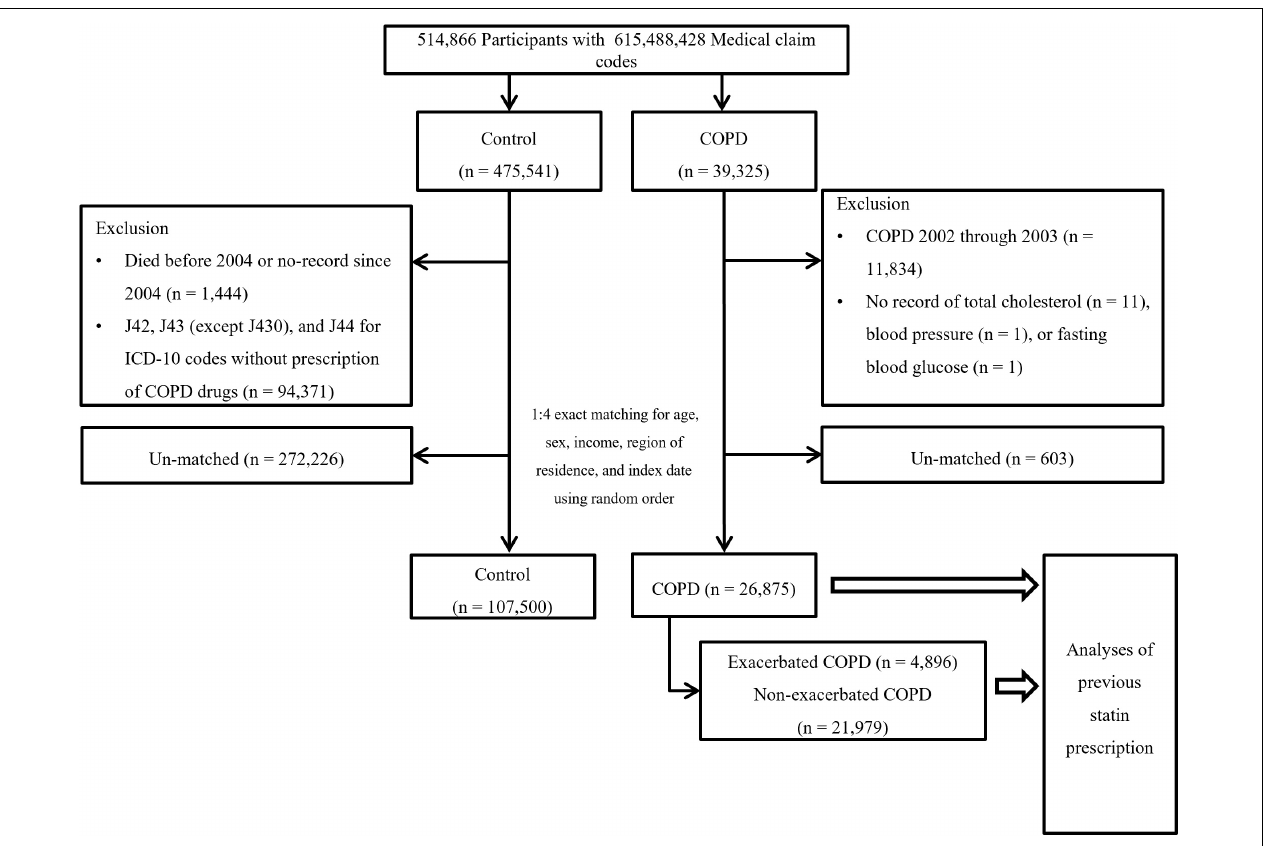
FIGURE 1 | Schematic illustration of the participant selection process used in the present study. Of a total of 514,866 participants, 26,875 participants with COPD were matched with 107,500 control participants for age, sex, income, and region of residence (primary objective). The participants with COPD were classified